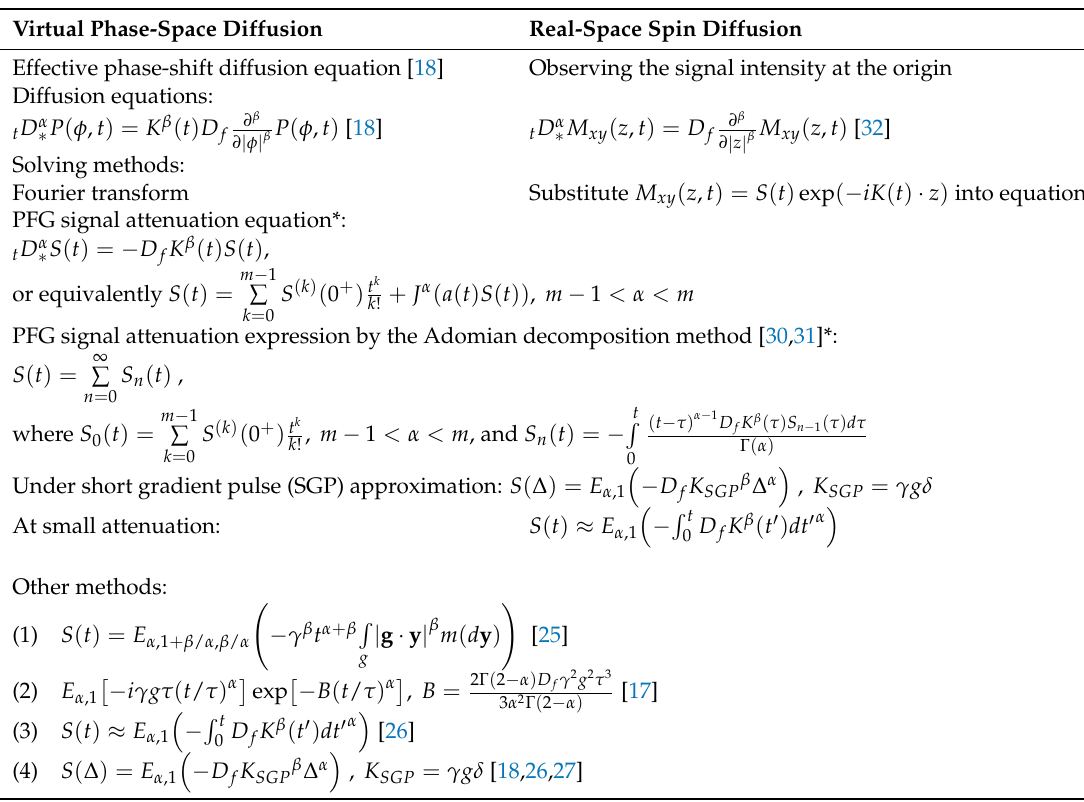
Table 1. Comparison of pulsed-field gradient (PFG) anomalous diffusion results by the effective phase-shift diffusion method, the observing the signal intensity at the origin method and other methods. Virtual Phase-Space Diffusion Real-Space Spin Diffusion Effective phase-shift diffusion equation [18] Observing the signal intensity at the